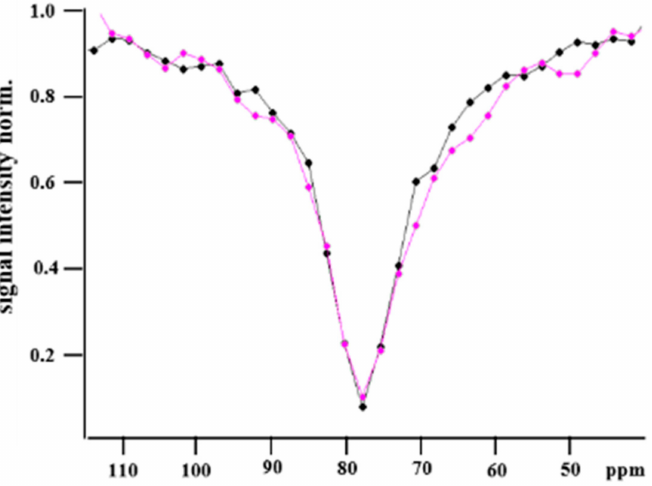
Figure 3. CEST resonance of hpXe bound to Y2R-A202C-CrA conjugate alone (black) and in complex with NPY (magenta). Continuous lines connect experimental data (dots) as a guide for the eye.